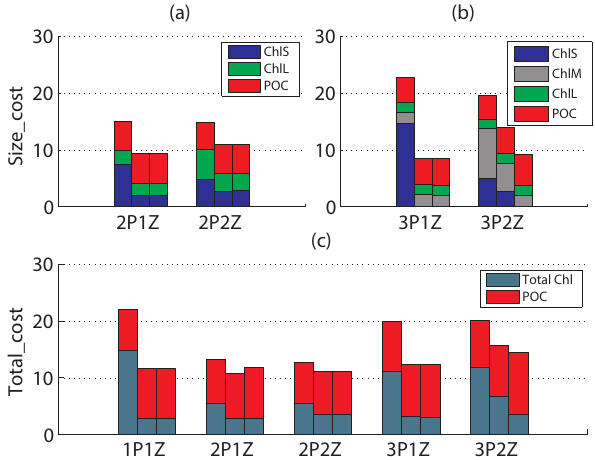
Figure 3. Cost functions at the four DA sites: (a) Size_cost for the 2P models, (b) Size_cost for the 3P models and (c) Total_cost for all five models. The three bars (from left to right) for each model represent the costs obtained for experiment 1 (a priori cost), exper- iment 2 (a posteriori cost) and experiment 3 (a posteriori case with noise), respectively. Colors represent the various components (total chlorophyll, size-fractionated chlorophyll and POC) of these